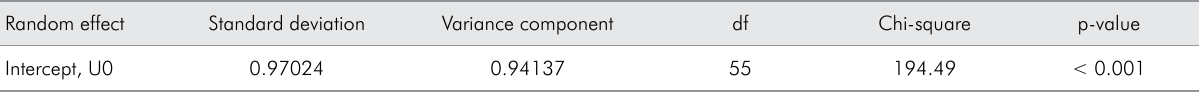
Table 4. Final estimation of variance components in the multilevel analysis